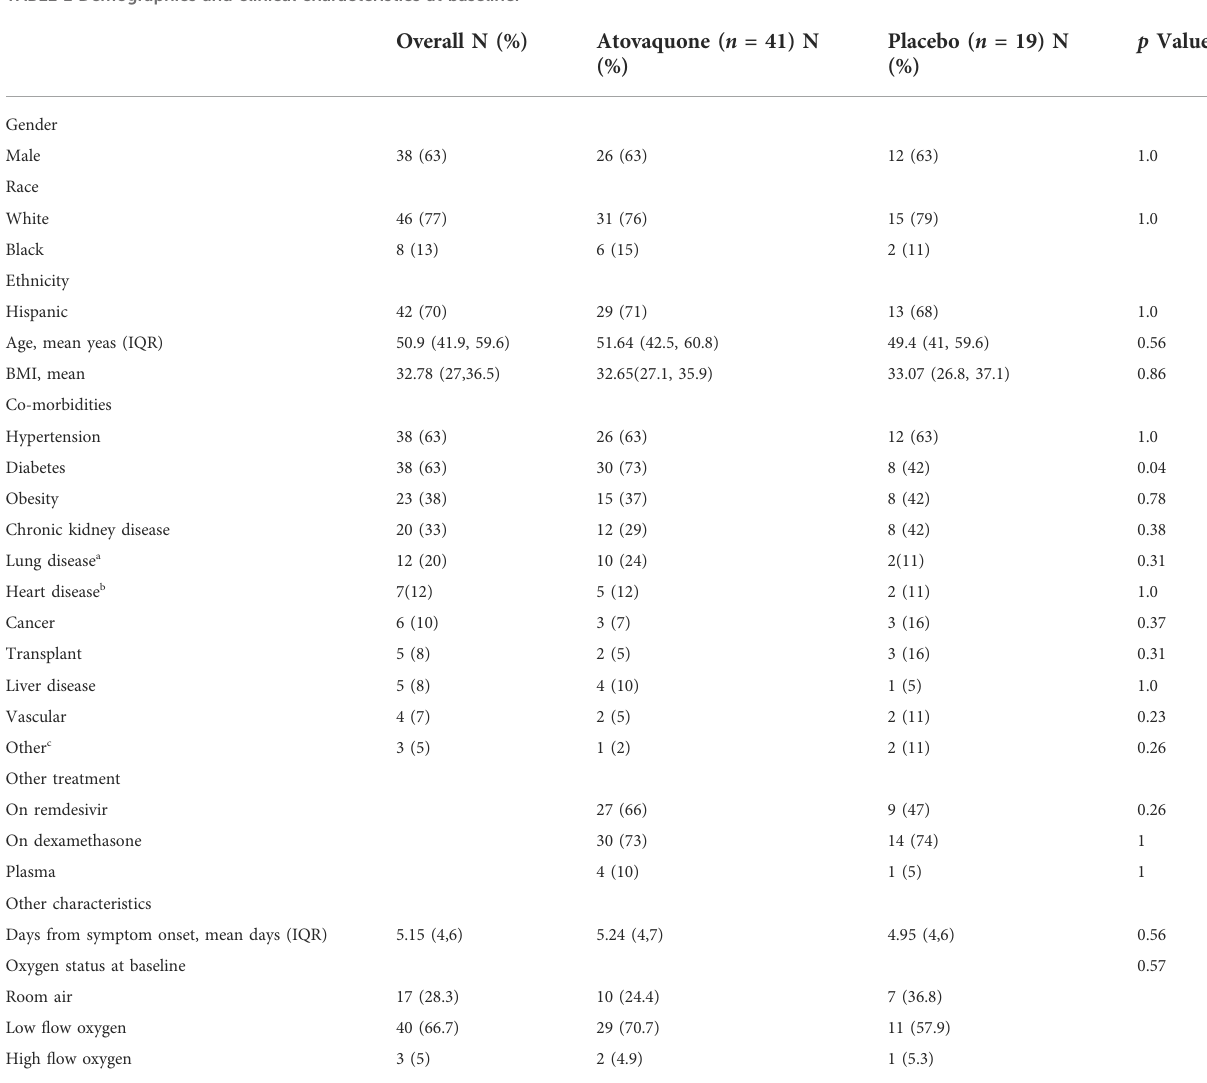
TABLE 1 Demographics and clinical characteristics at baseline.